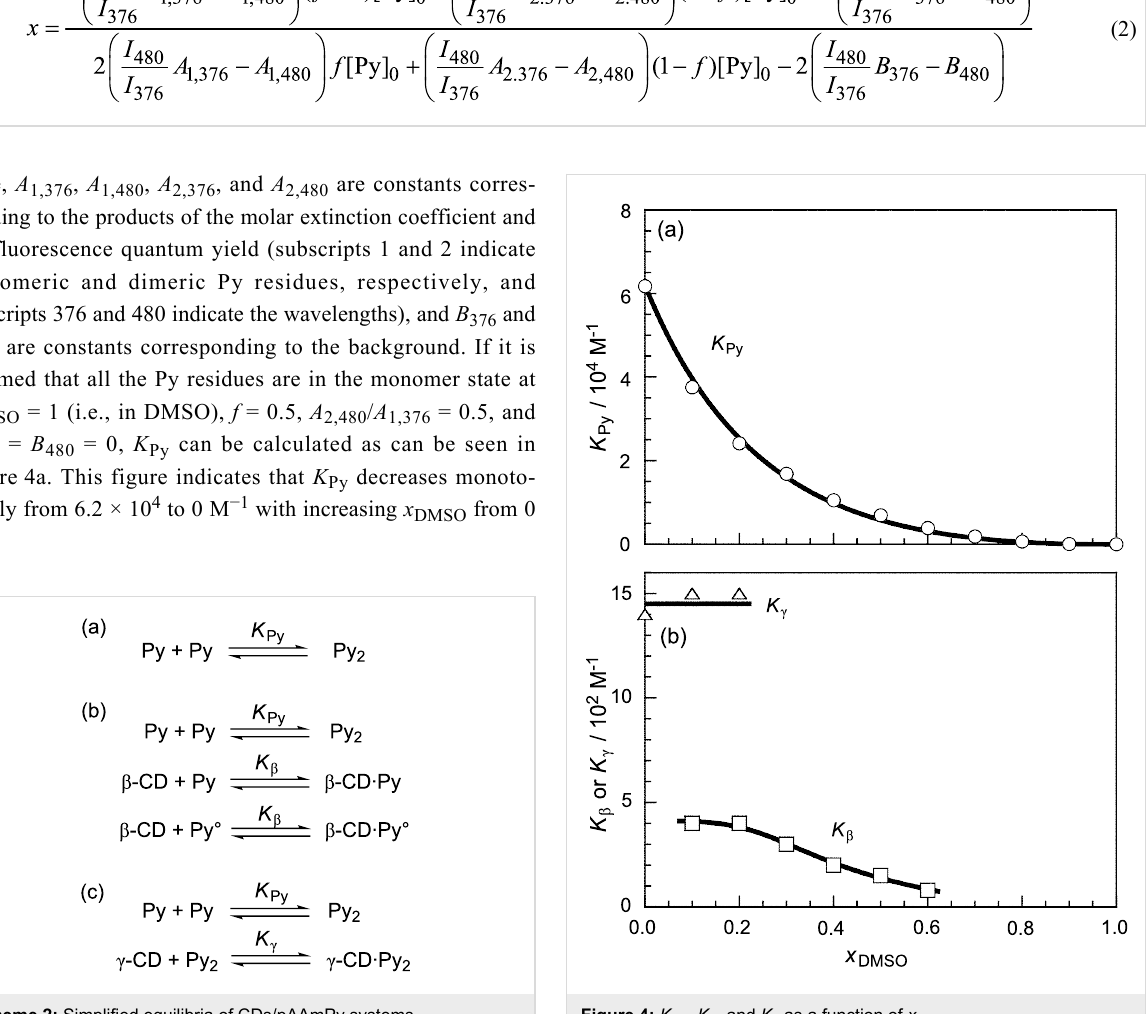
Figure 4: K Py , K β , and K γ as a function of x DMSO .